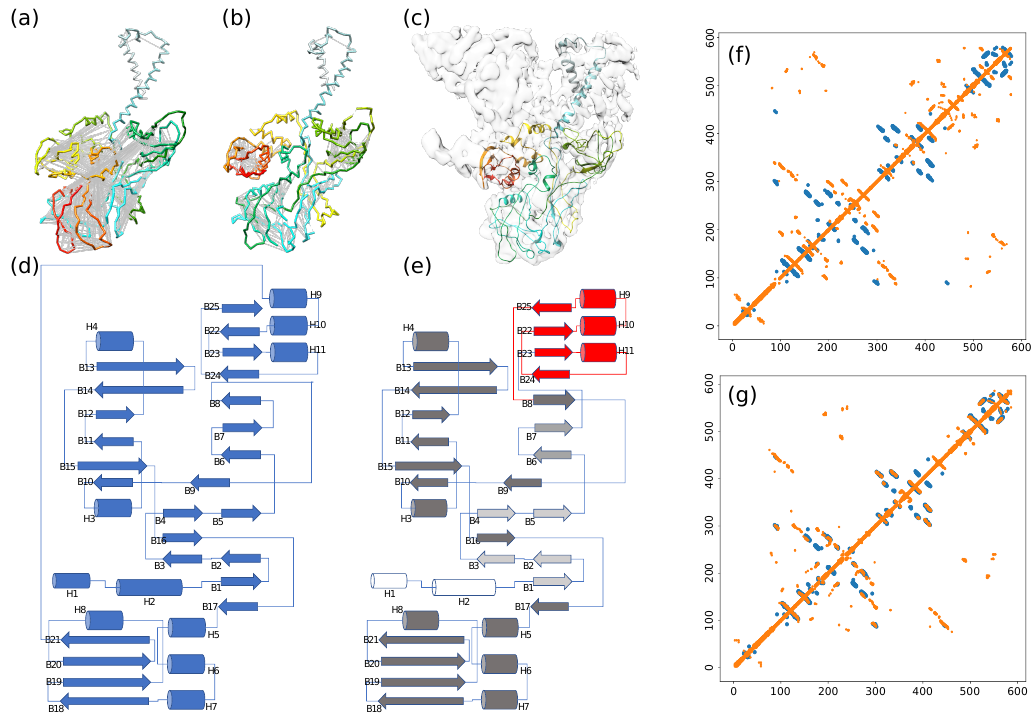
Figure 7. Modified methodology to determine the structure of the wedge complex of the bacterial type 6 secretion system (T6SS) baseplate. ( a ) Initial model manually built in the EM density map. ( b ) Corrected model using predicted contacts. Gray lines correspond to contacts predicted by RaptorX, mostly unsatisfied in the initial model. The rainbow color of the backbone reports the residue index, where N-terminal residues are blue, and C-terminal residues are red. ( c ) Final atomic model docked in the EM map to the wedge complex. ( d ) Topology of the initial model depicted in ( a ). ( e ) Topology of the corrected model depicted in ( b ). The red part highlights the major topology changes made by the method (fragmentation/concatenation). The gray scale encodes the sequence offset introduced by the method: white secondary structure elements have no offset with respect to corresponding secondary structure of the initial topology, light gray elements have an offset of about 10 residues, dark gray have an offset of about 100 residues. ( f ) Contacts of the initial model (orange) aligned on the predicted contacts (blue). ( g ) Contacts of the final model (orange) aligned on the predicted contacts